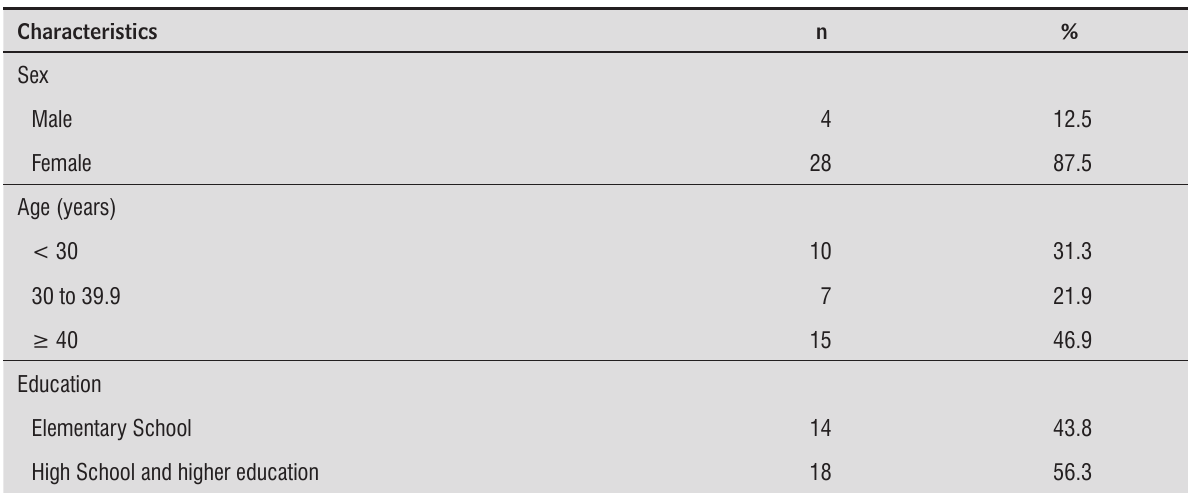
Table 1 - Socio-demographic characteristics of the obese adults, according to absolute (n) and relative ( % ) frequencies. Joinville, SC, Brazil, 2010